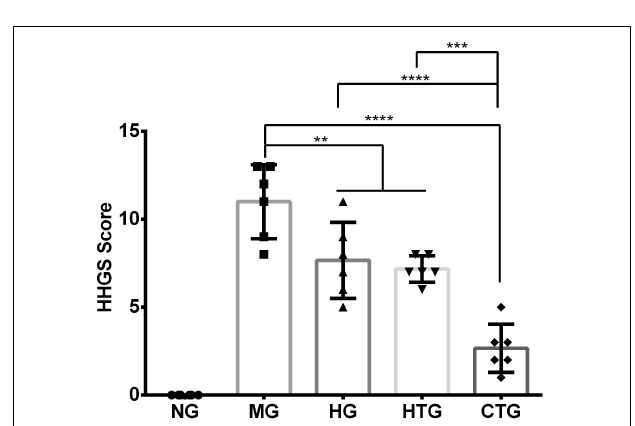
FIGURE 6 | HHGS scoring of the cartilage after 56 days of treatment. NG, LG-DMEM; MG, Model group; HG, 0.05 mg/mL HA; HTG, hAMSCs 1 × 10 6 ; CTG, HA (0.05 mg/mL) + hAMSCs (1 × 10 6 ). The data are expressed as mean ± sd ( n = 6), ** P < 0.01, *** P < 0.001, **** P <